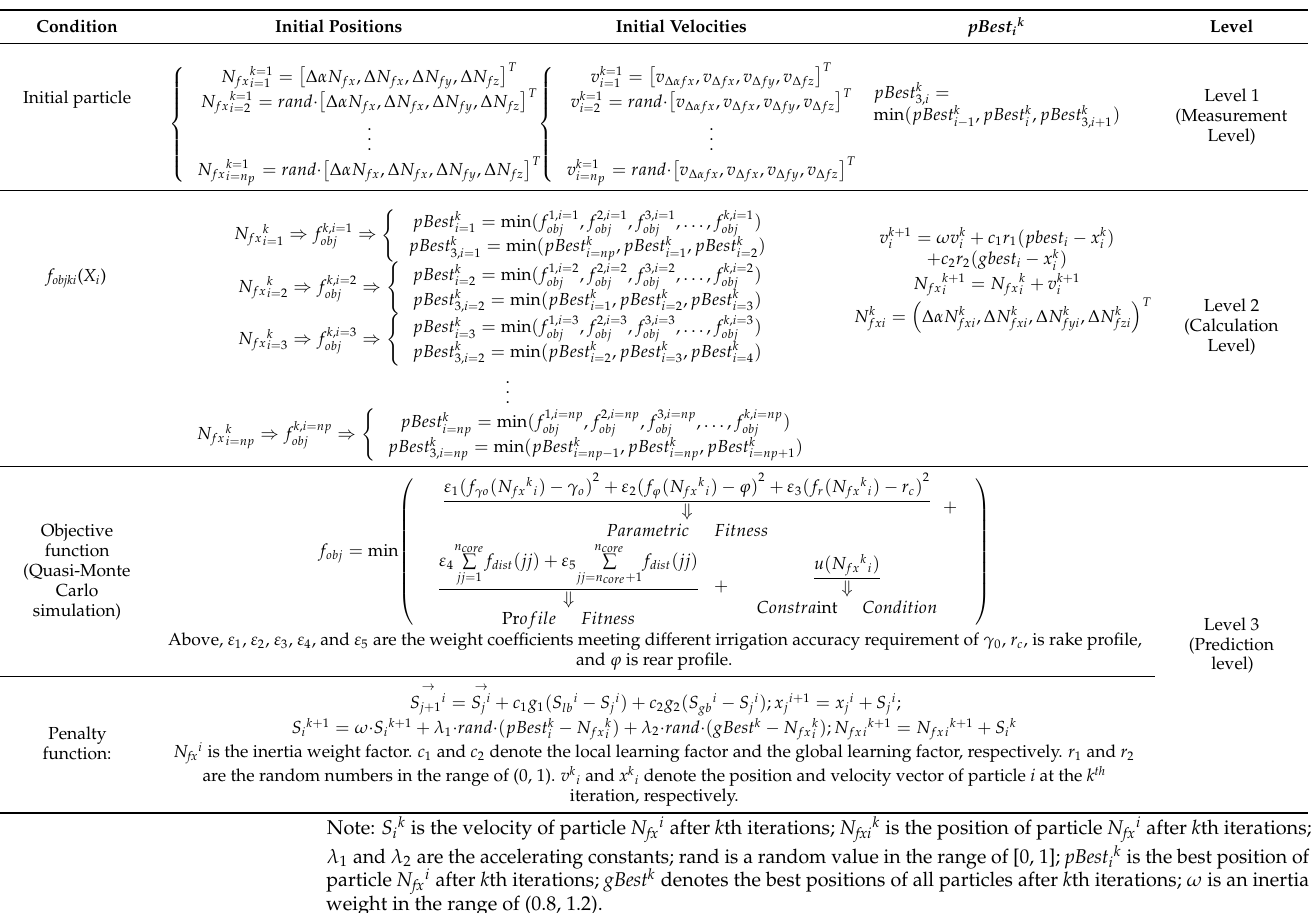
Table 1. Parametric arrangements of the RSAE-NPSO